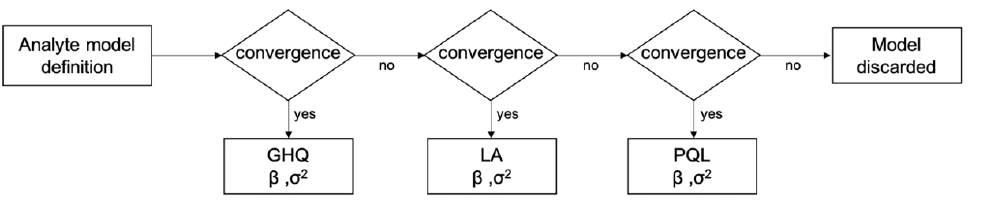
Figure 1. OLME model parameters estimation